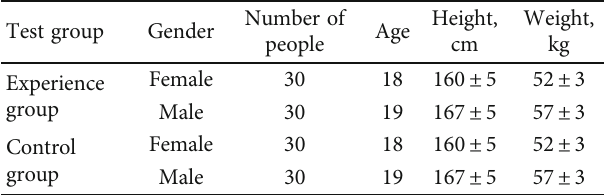
Table 1: Basic information table of experimental